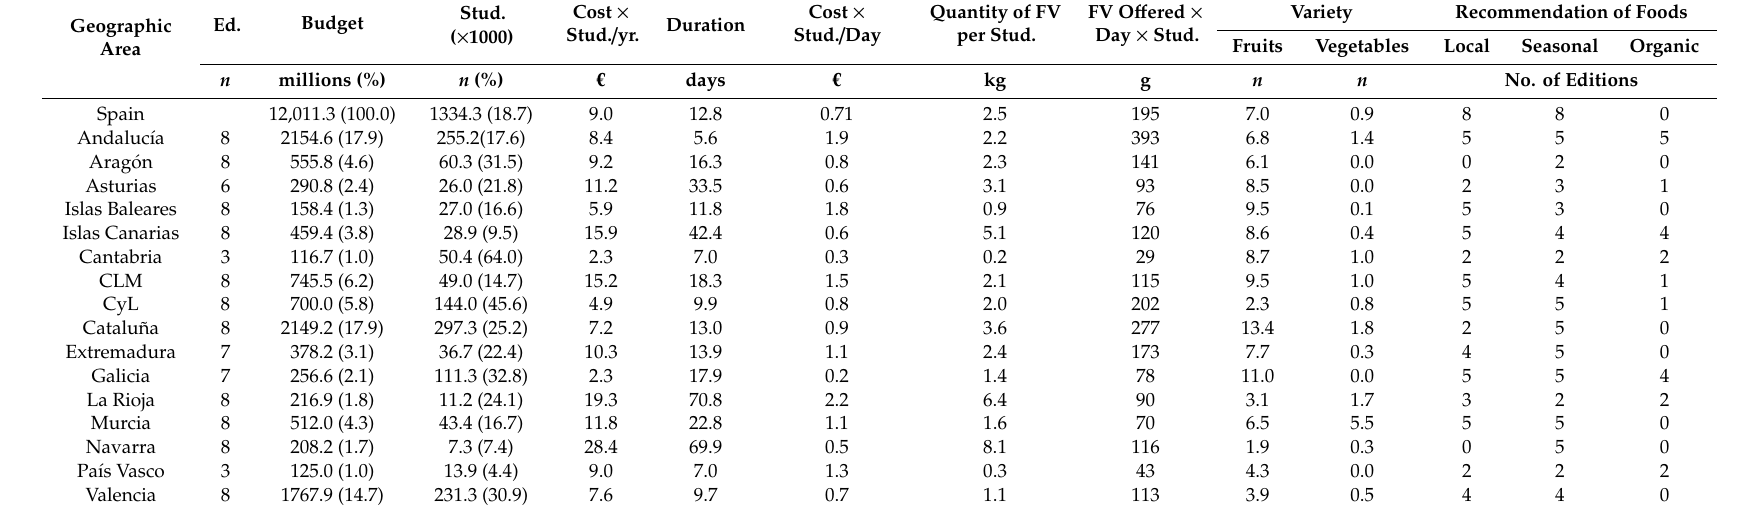
Table 2. Characteristics of the School Fruit and Vegetables Scheme by AC: averages for the 2009–2017 period. Geographic